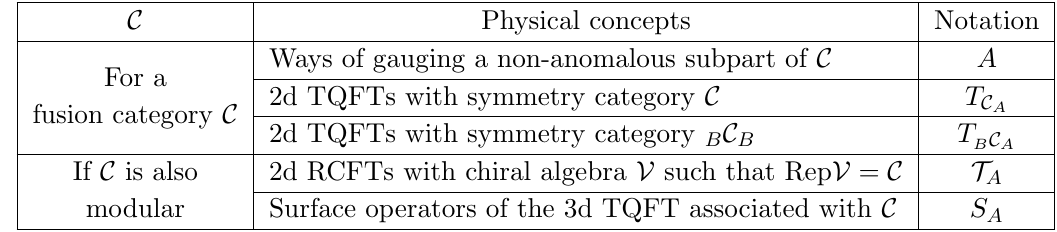
Table 1. The physical concepts that are in one-to-one correspondence. Given a modular tensor category C , every physical concept in the above table is uniquely determined by the Morita equiv- alence class of a symmetric Frobenius algebra A in C . When C is only a fusion category, only the (cid:12)rst two rows are in one-to-one correspondence. In the third row, B denotes a way of gauging a subpart of C .